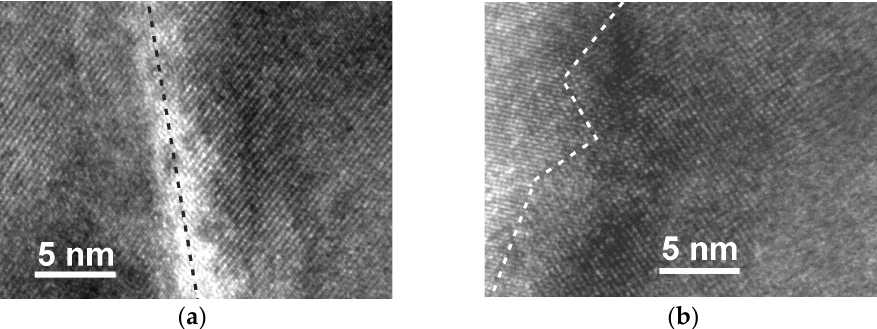
Figure 5. HR TEM image of an interface between the two adjacent LSMO grains of films grown on quartz ( a ) and Si/SiO 2 ( b ) substrates.